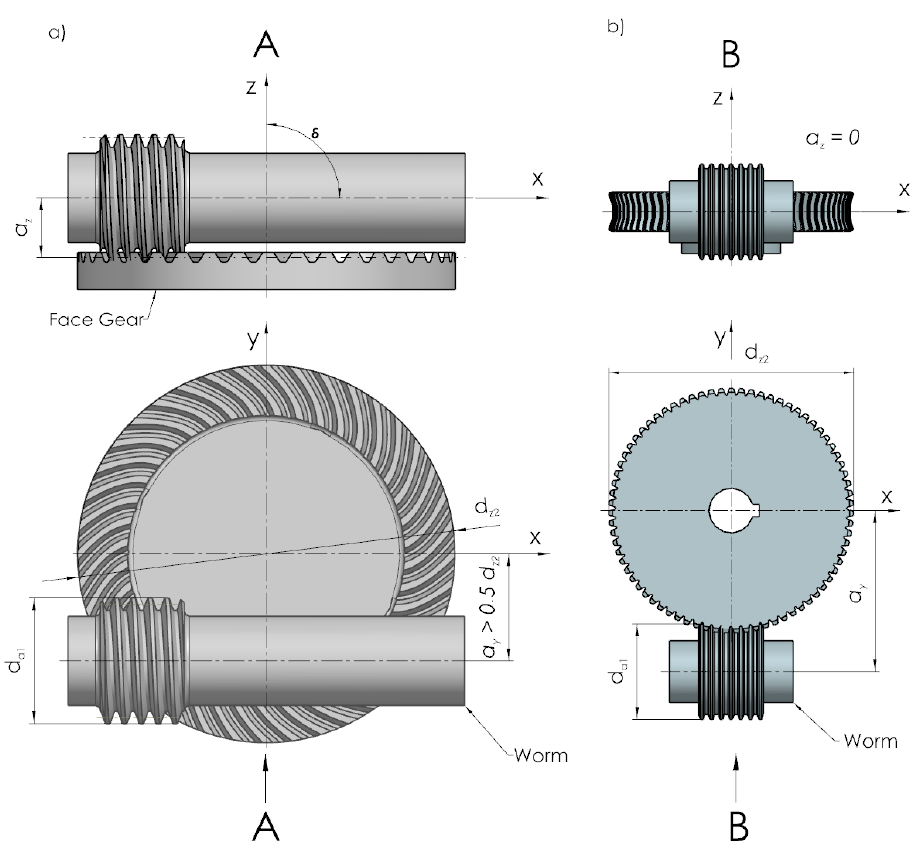
Figure 1. Location of wheels in ( a ) spiroid gear and ( b ) worm gear. Worm gears have a line contact, whereas spiroid gears have a point contact. Both types of gears have a common disadvantage: they may heat up.